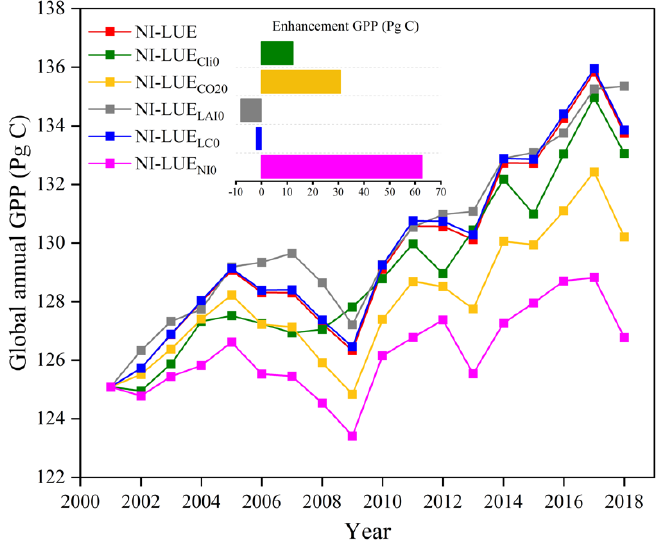
Figure 15. Interannual variation of the global annual total GPP (NI-LUE i 0 ) with variable i fixed at the initial state.